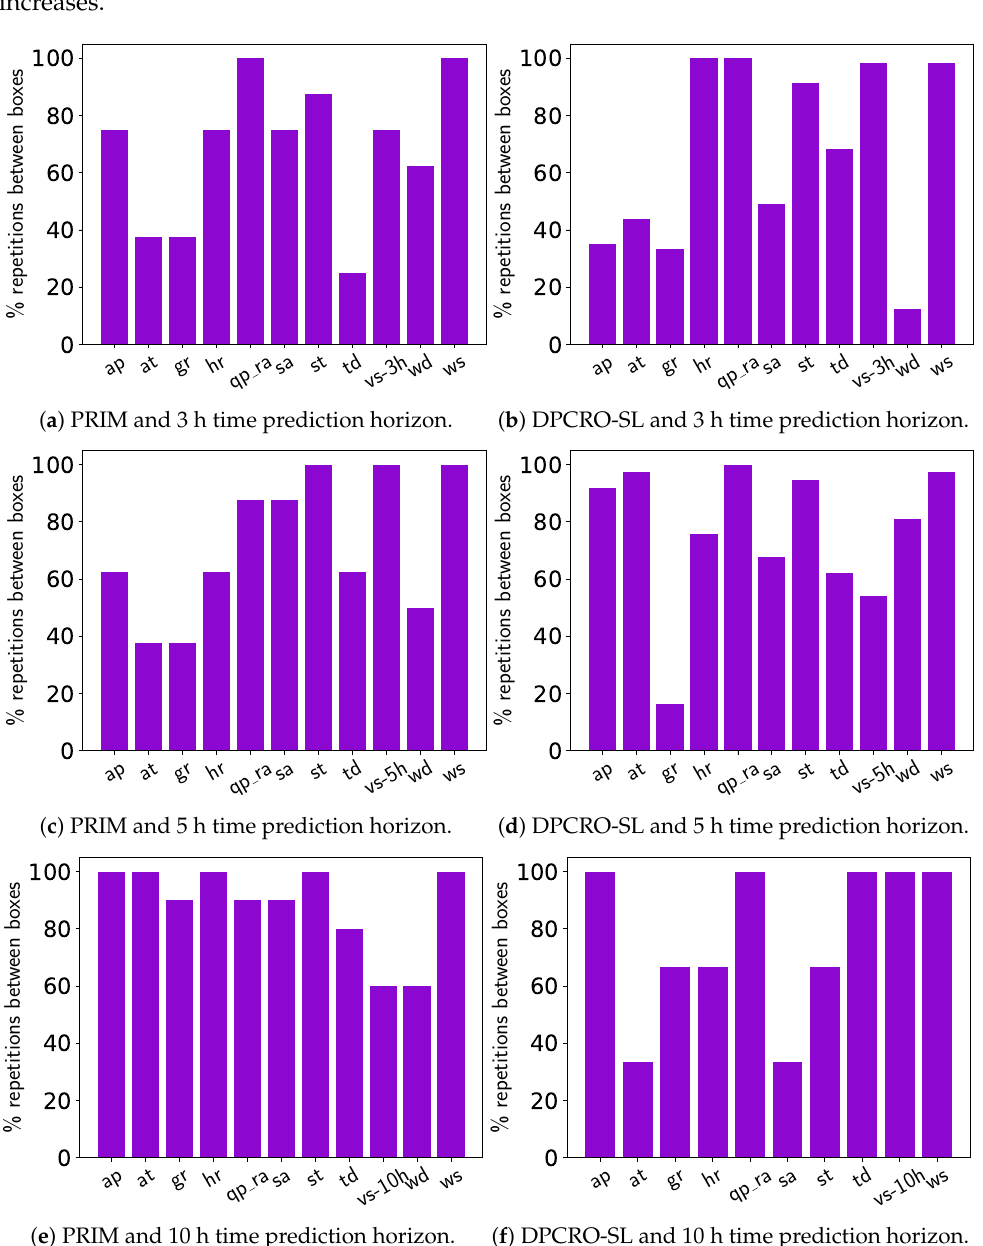
Figure 10. Bar charts with the percentage of repetitions between boxes of rules for each variable with PRIM and